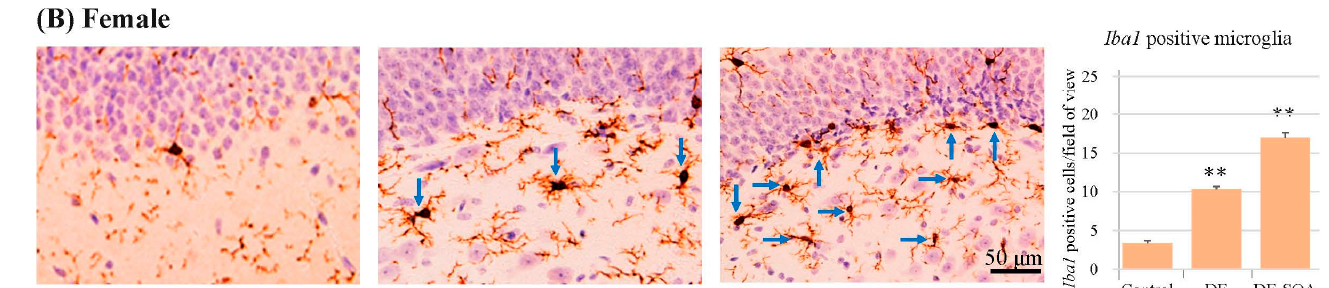
Figure 9. Representative photomicrographs of the dentate gyrus of the hippocampus. Microglia marker Iba1 immunoreactivity in 10-week-old ( A ) male and ( B ) female rats of the control and the DE- or DE-SOA-exposed groups. Blue arrows indicate activated microglia. (Scale bar = 50 μ m). Number of Iba1 -positive cells located within the DG area of the hippocampus was quantified in a high-power field under microscopy (histogram). ( n = 5, ** p < 0.01 vs. control).